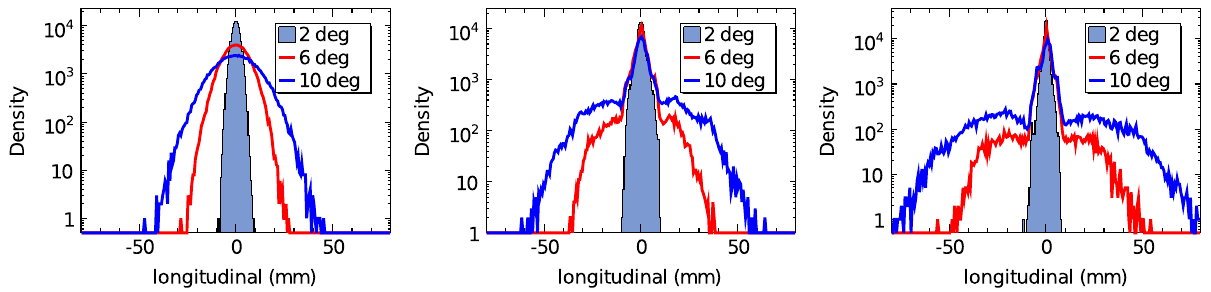
FIG. 10. (Color) Histogram of 3 mA bunch distributions with 2 (cid:6) , 6 (cid:6) , and 10 (cid:6) initial phase widths at initial position (left), turn 50 (middle), and 150 (right) in the PSI ring cyclotron.